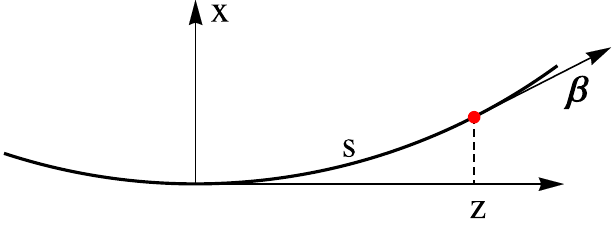
FIG. 2. A part of a circular orbit with coordinate